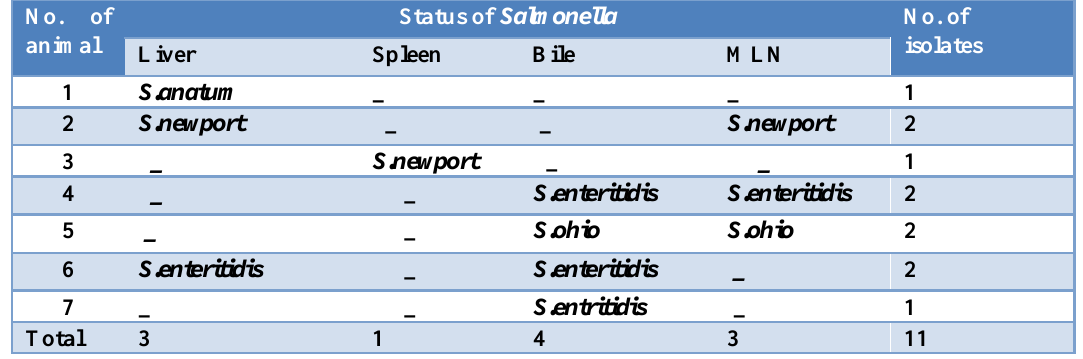
Table, 4: Distribution of Salmonella isolate according toage of animals Cow